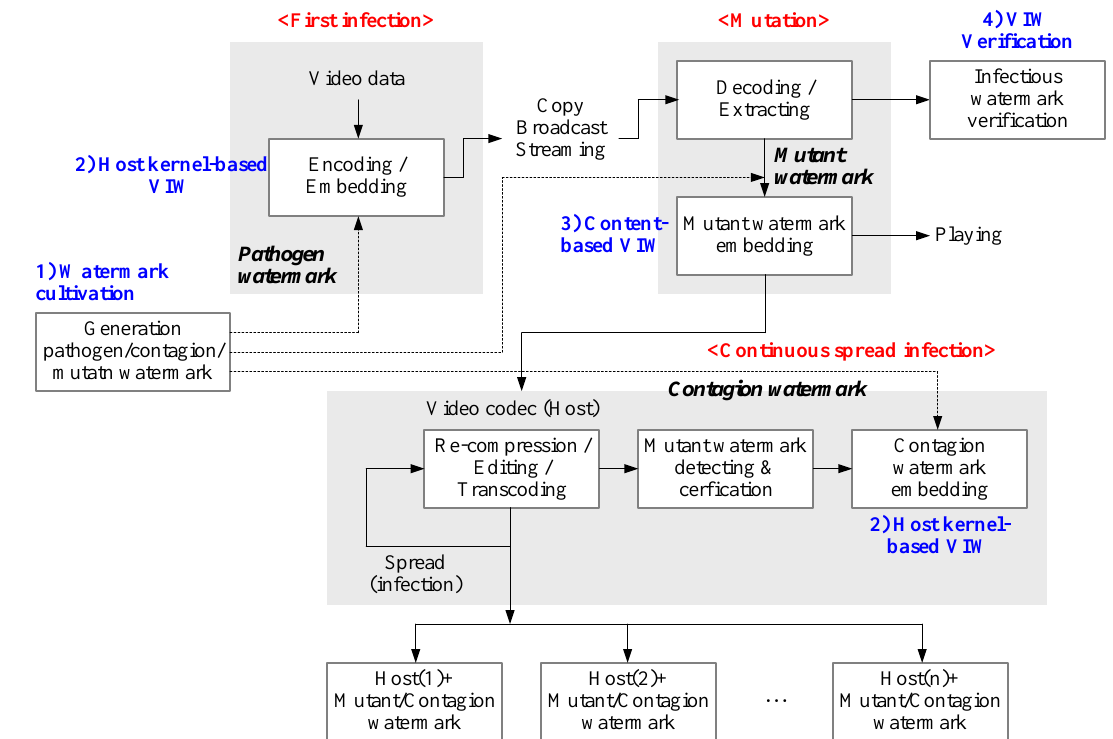
Figure 2. Viral infectious watermarking (VIW) model in video codec.